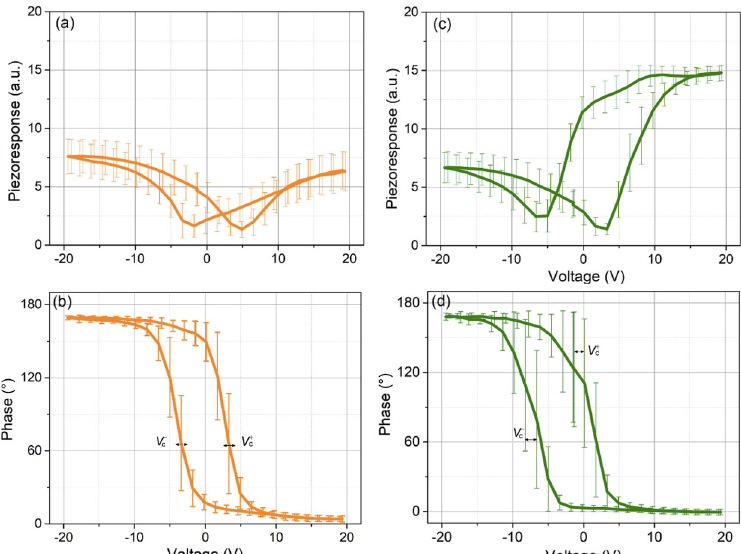
Fig. 2 Comparisons of PFM hysteresis loops between the (a, b) middle and (c, d) side domains. Hysteresis loops shown are the average results of 100 points in the respective domains. Positive bias + correspond to voltage ranges where error bars maximize in hysteresis phase loops. + where drastic variation in phase